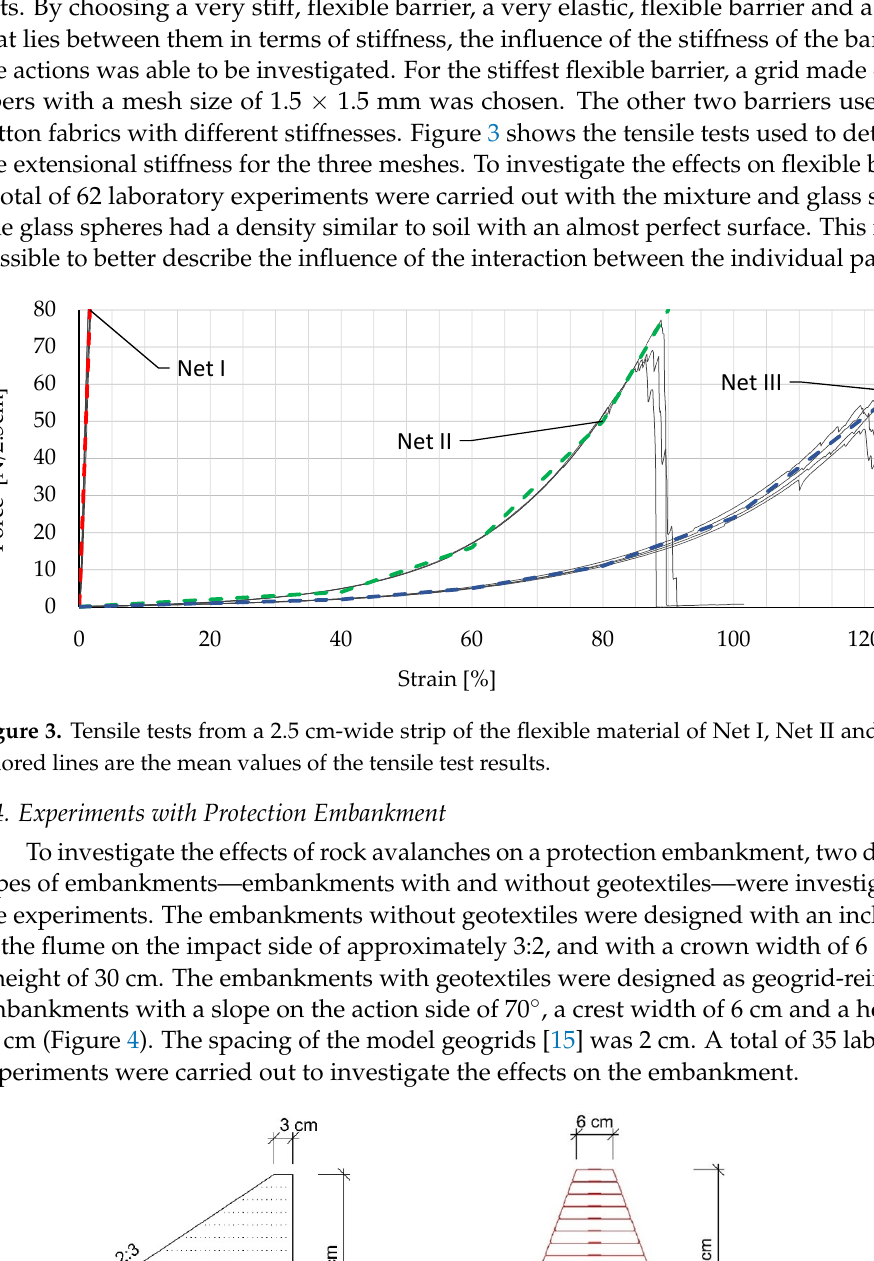
Figure 4. Geometry of the two types of embankments: ( a ) earth dam without geotextiles, inclination 2:3 on the impact side; ( b ) reinforced dam with geotextiles, inclination 70° on the impact side.